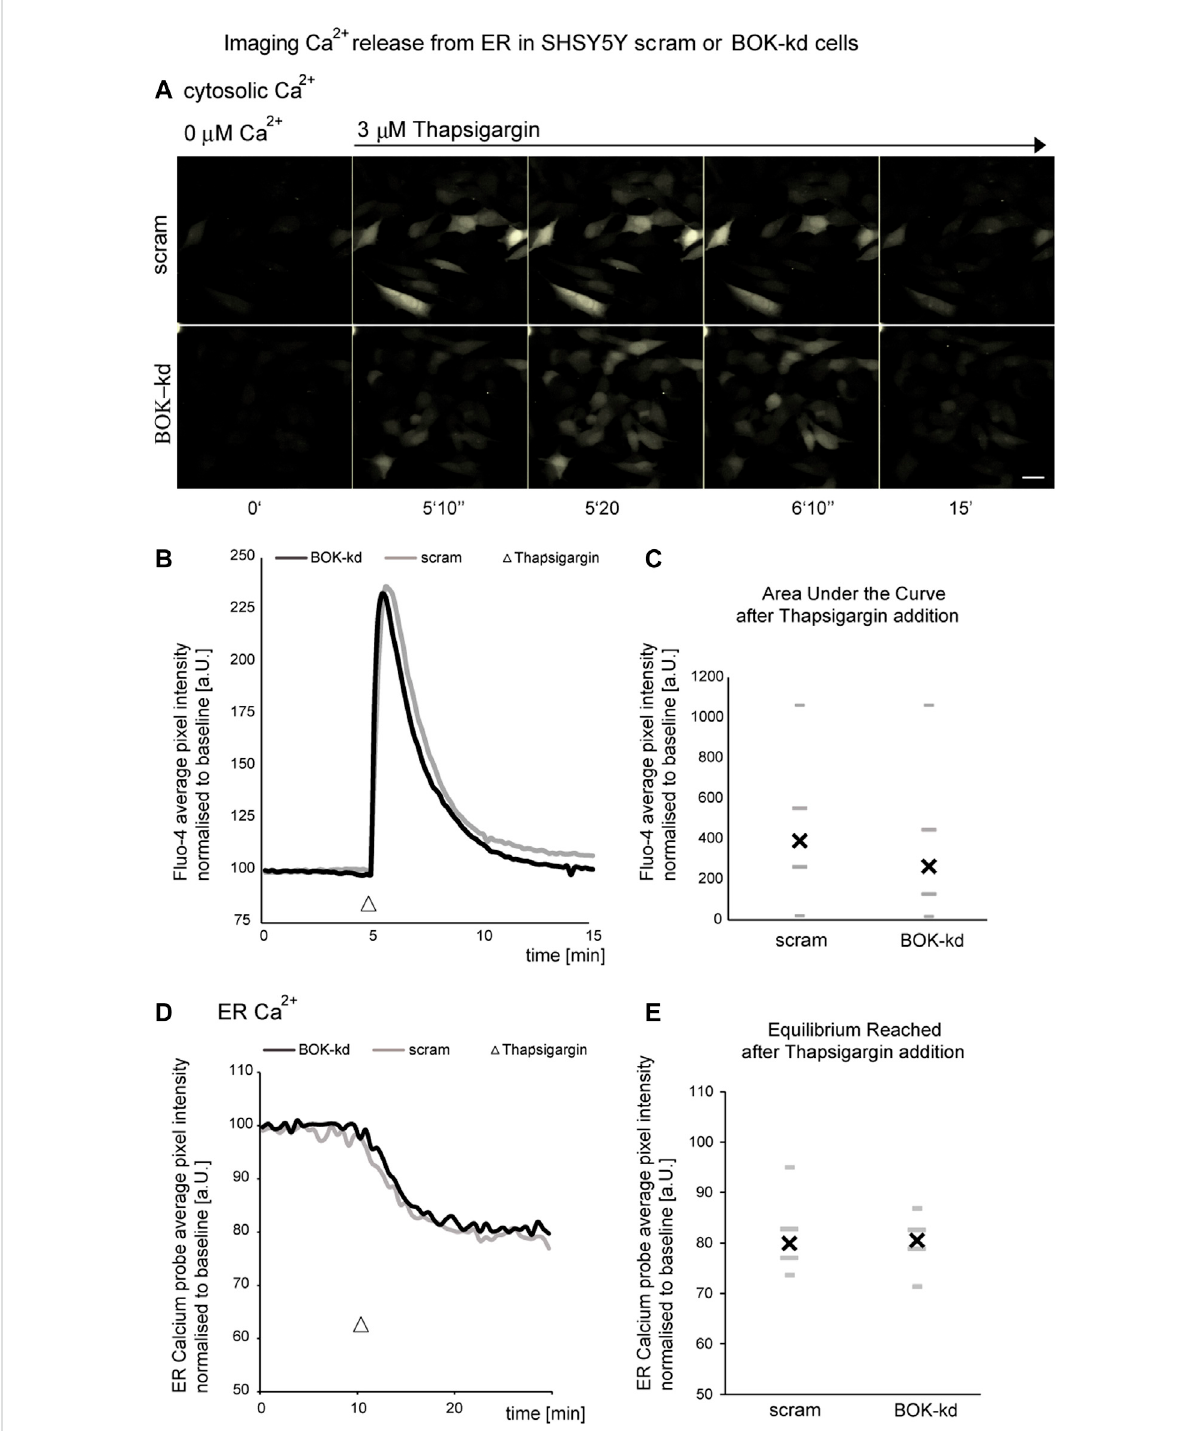
FIGURE 4 BOK de fi ciency does not result in ER calcium dysregulation. SHSY5Y cells stably expressing shRNA against BOK or scram control stained with Fluo-4 wereimagedinKrebsbufferwithoutextracellularcalciumevery 10 s. (A,B) Treatmentwith3 μ Mthapsigargincausedarapidtransientspikein fl uorescence intensity. (A) Representative images of one out of four experiments are shown (scale bar 20 μ m ) . (B) Average kinetics for all experiments, ( n = 79 cells BOK-kd or ctrl analyzed for all experiments). (C) There was no difference in the median overall area under the curve above between scram control and BOK-kd cells (* indicates p = 0.3942; Mann – Whitney U-test). SHSY5Y cells stably expressing shRNA against BOK or scram control, transfected with the ERD1CPV vector, were imaged in Krebs buffer without extracellular calcium every 30 s. (D,E) Treatment